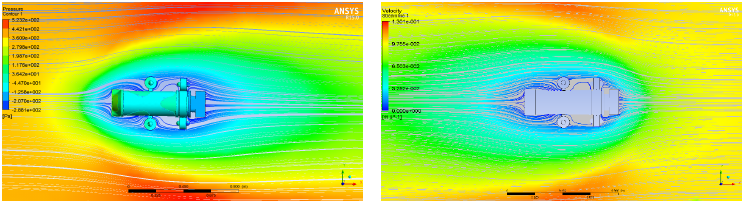
Figure 6. Left diagram shows the flow around Shark-AUV cruising along + x -direction; the right one shows flow around Shark-AUV cruising along − x -direction.